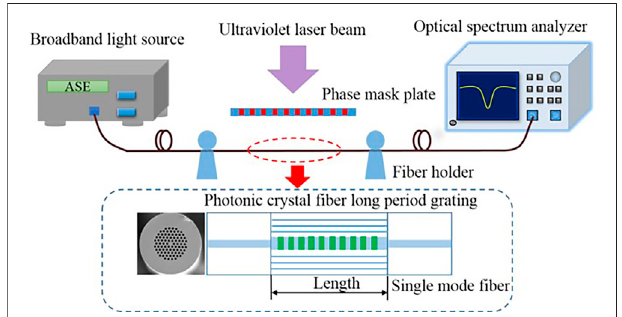
FIGURE 3 | Schematic of the measurement system and its sensing structure